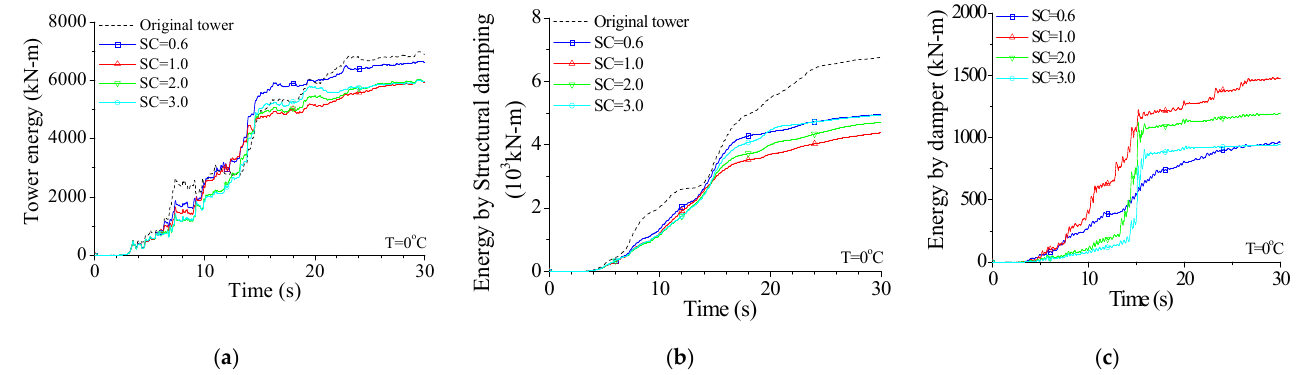
Figure 20. Variation of energy responses with damper stiffness. ( a ) Tower energy; ( b ) Energy by structural damping; ( c ) Energy by damper.